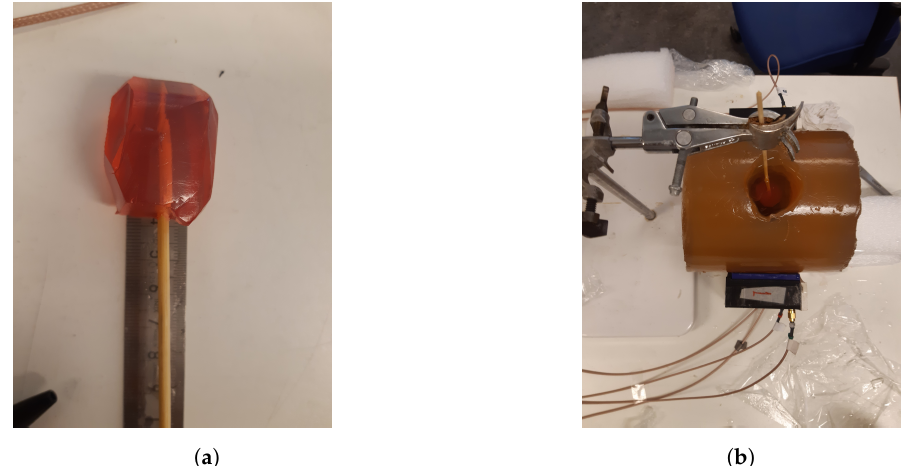
Figure 7. The blood phantom and muscle phantom that were used in the image reconstruction exper- iments: ( a ) blood phantom; ( b ) top view of the muscle